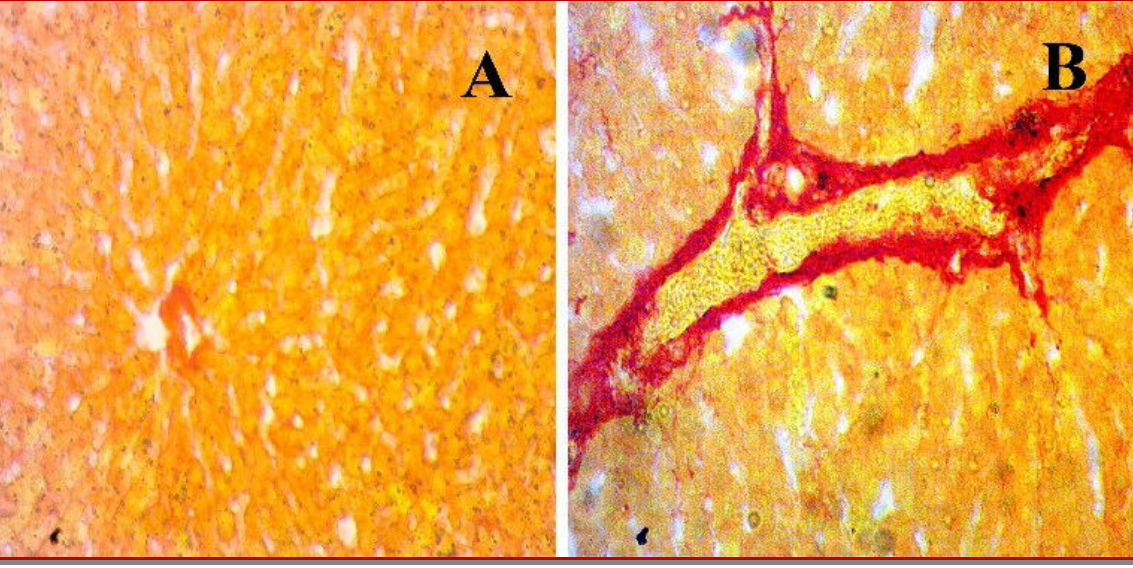
Figure 4: Sirius red staining showed fibrosis (red color) in liver of rats treated with CCl 4 . A, Control; B, CCl 4 , Magnification